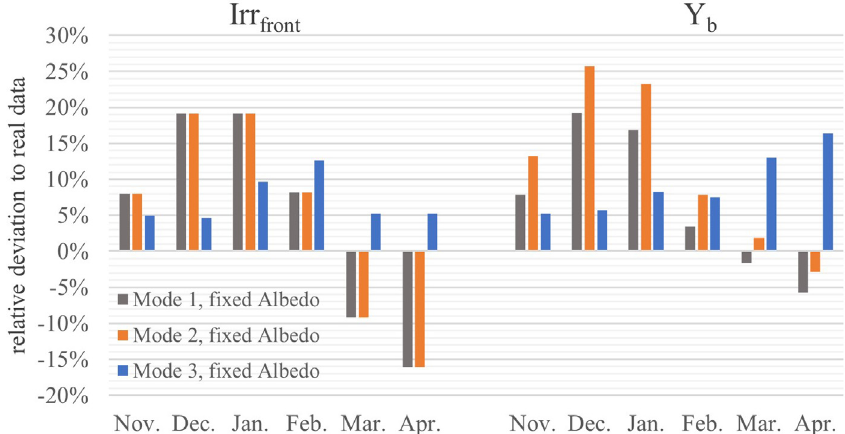
Fig. 2. The fi gure shows the relative deviation between simulation data and measured data of the front irradiance Irr front and the area- speci fi c energy yield Y b in the time frame of November 2019 to April 2020. Mode 1 and 2, which use VF for front side irradiance calculation, show the same results for Irr front . The largest positive deviation is 19% in December and the largest negative difference is (cid:2) 16% in April. Mode 3, which uses RT, shows only positive deviations. The front irradiance deviations also translate over to the energy yield Y b . Here mode 2, which uses only VF, calculates the highest deviations between simulation and measured data. The in fl uence of RT for the calculation of the rear irradiance can be seen in the lower deviations of mode 1. The pure RT simulation mode 3 only produces positive deviations, which are highest in April with 16%.